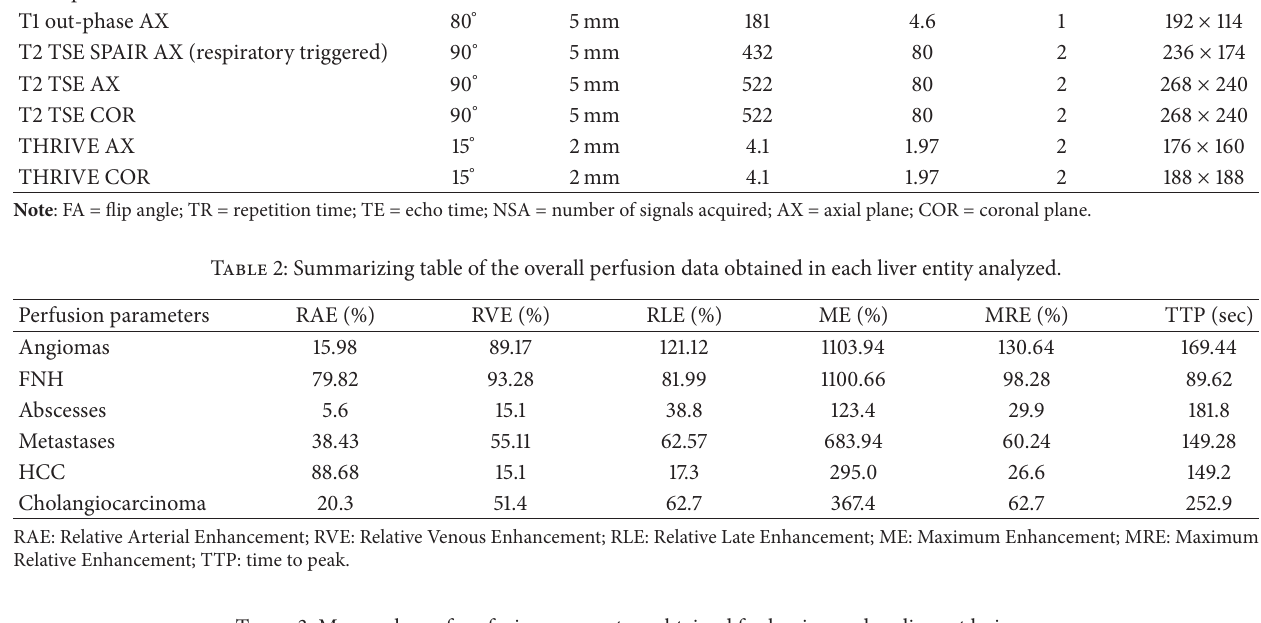
Table 3: Mean values of perfusion parameters obtained for benign and malignant